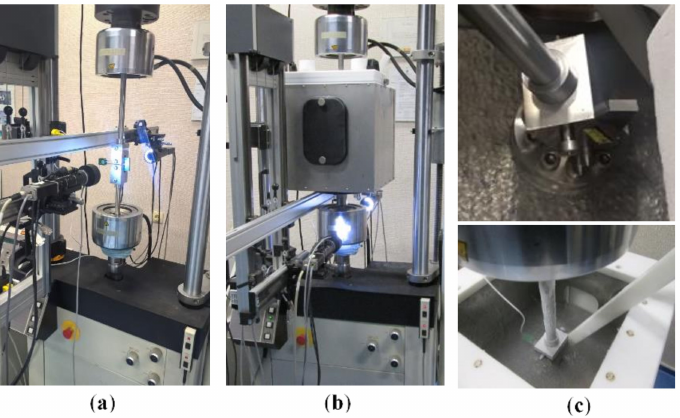
Figure 3. Test stand: ( a ) stand for generation of fatigue crack and tests at ambient temperature; ( b ) stand with an environmental chamber and ( c ) view inside the